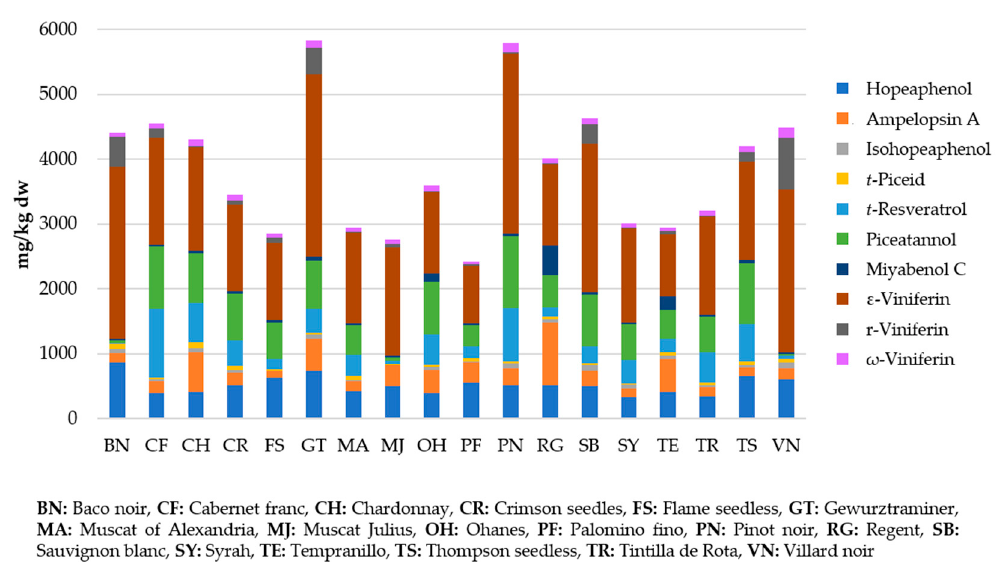
Figure 2. Stilbene concentrations in grapevine canes from different varieties of Vitis vinifera (Adapted from [70]).